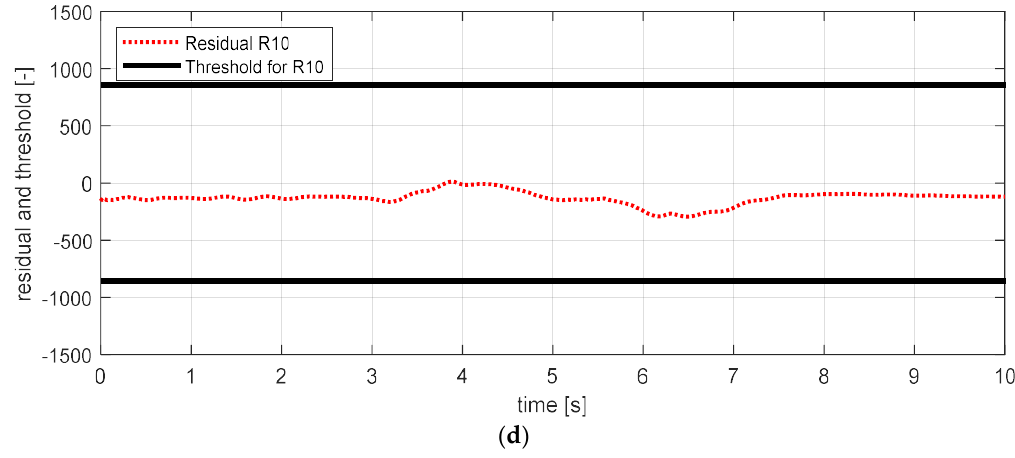
Figure 19. FDI simulation result for longitudinal acceleration sensor (normal). ( a ) Residual 7 and threshold; ( b ) residual 8 and threshold; ( c ) residual 9 and threshold; ( d ) residual 10 and threshold.